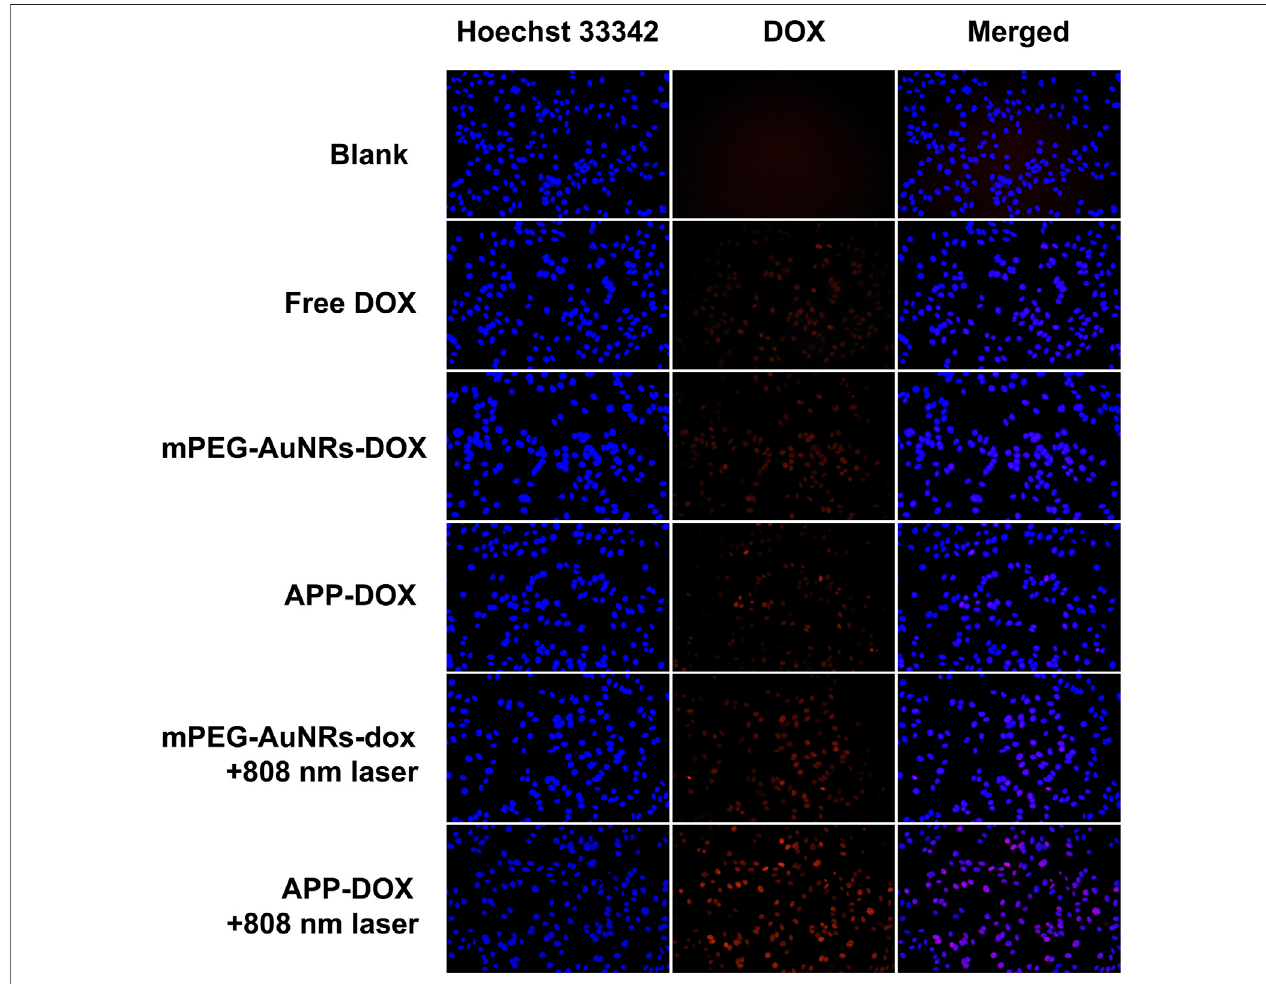
FIGURE 3 | Fluorescence microscopic images of HepG2 cells incubated with free DOX, mPEG-AuNRs-DOX, and APP-DOX for 4 h (scale bar represents 10 µm).